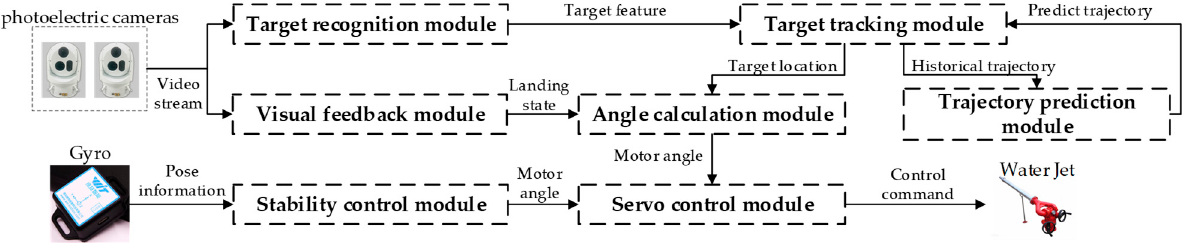
Figure 2. System software module.